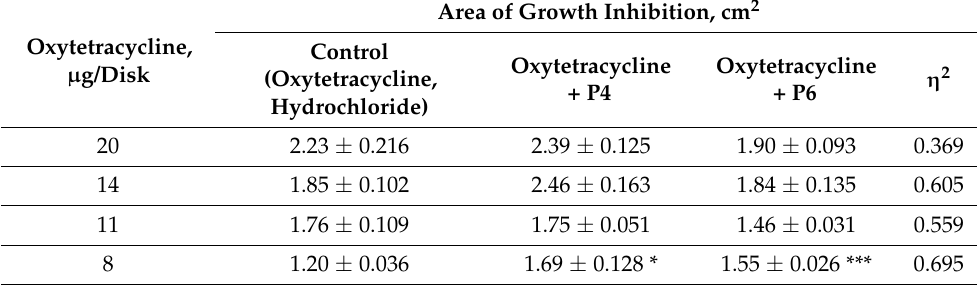
Table 2. Area of growth inhibition of Escherichia coli .